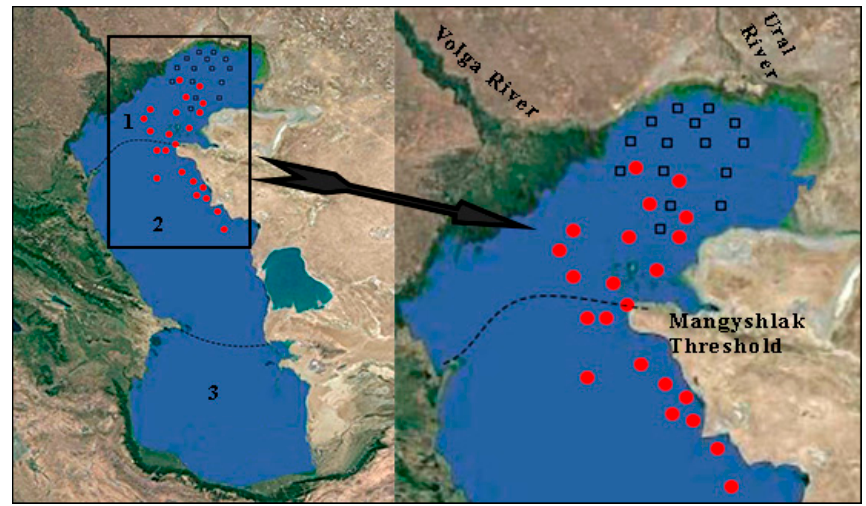
Figure 1. Map of sampling stations in the Kazakhstan sector of the Caspian Sea in 2008 and 2010. Dotted lines are the boundaries between the Northern (1), Middle (2), and Southern (3) Caspian. Circles are the stations for material selection in 2008, squares—the stations for material selection in 2010.